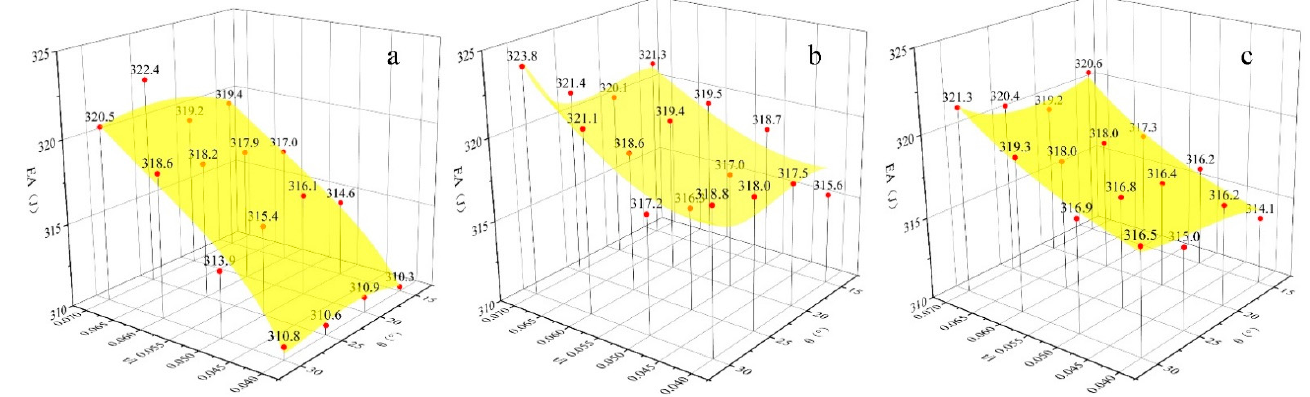
Figure 8. Energy absorption of the honeycomb structure with different Poisson’s ratios at 50 m/s impact speed: ( a ) Poisson’s ratio is positive; ( b ) Poisson’s ratio is negative; ( c ): Poisson’s ratio is zero.